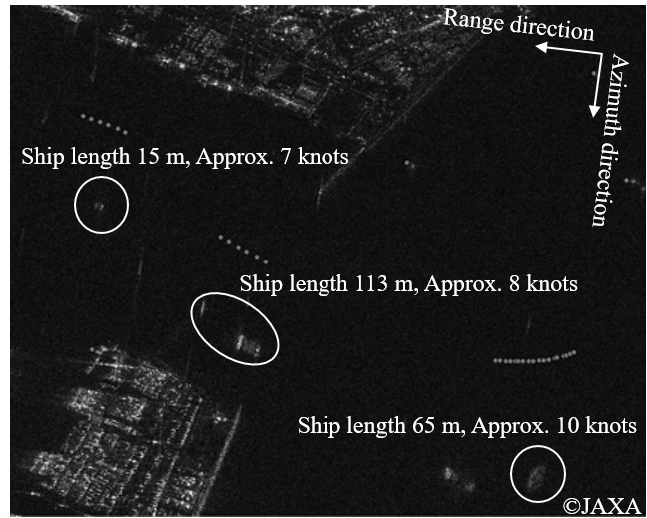
Figure 6. Example of range moving ships in a Spotlight SAR image compared with AIS data. The continuous dots show the trail of ship by AIS over one minute. The small ship moving to the range direction is difficult to image; meanwhile, the relatively large ships moving in the range direction can be imaged but not focused well.